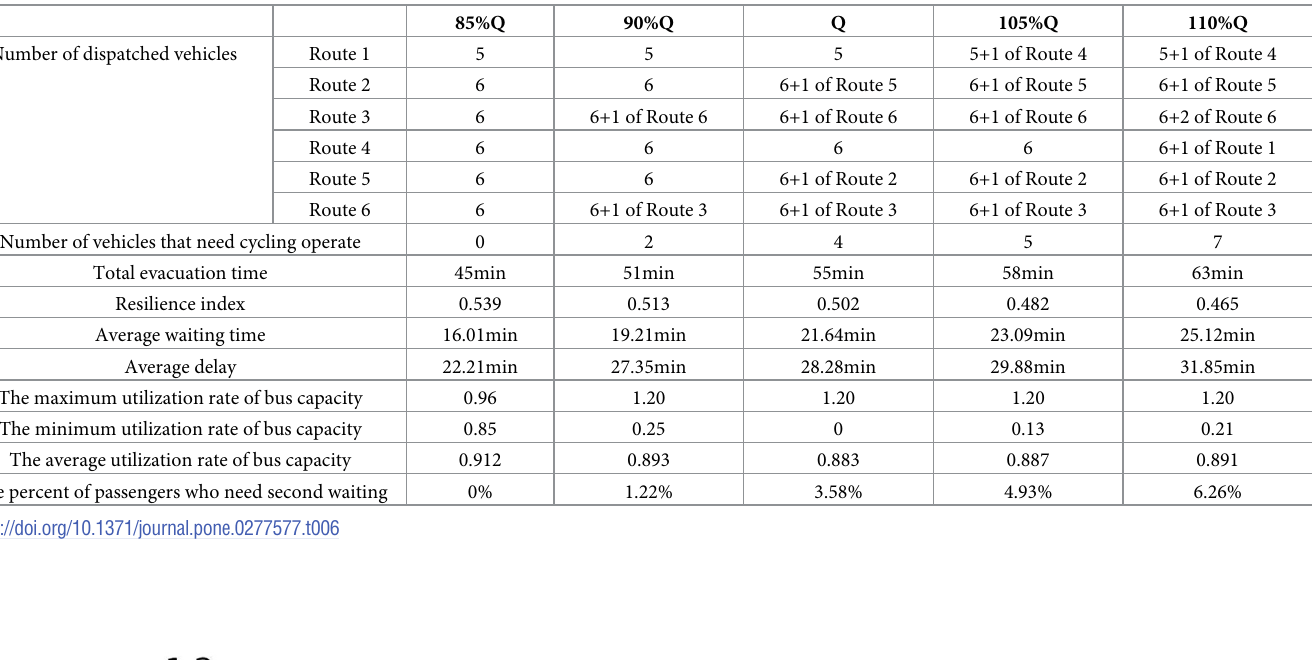
Table 6. The sensitivity analysis of fluctuating evacuation demand.